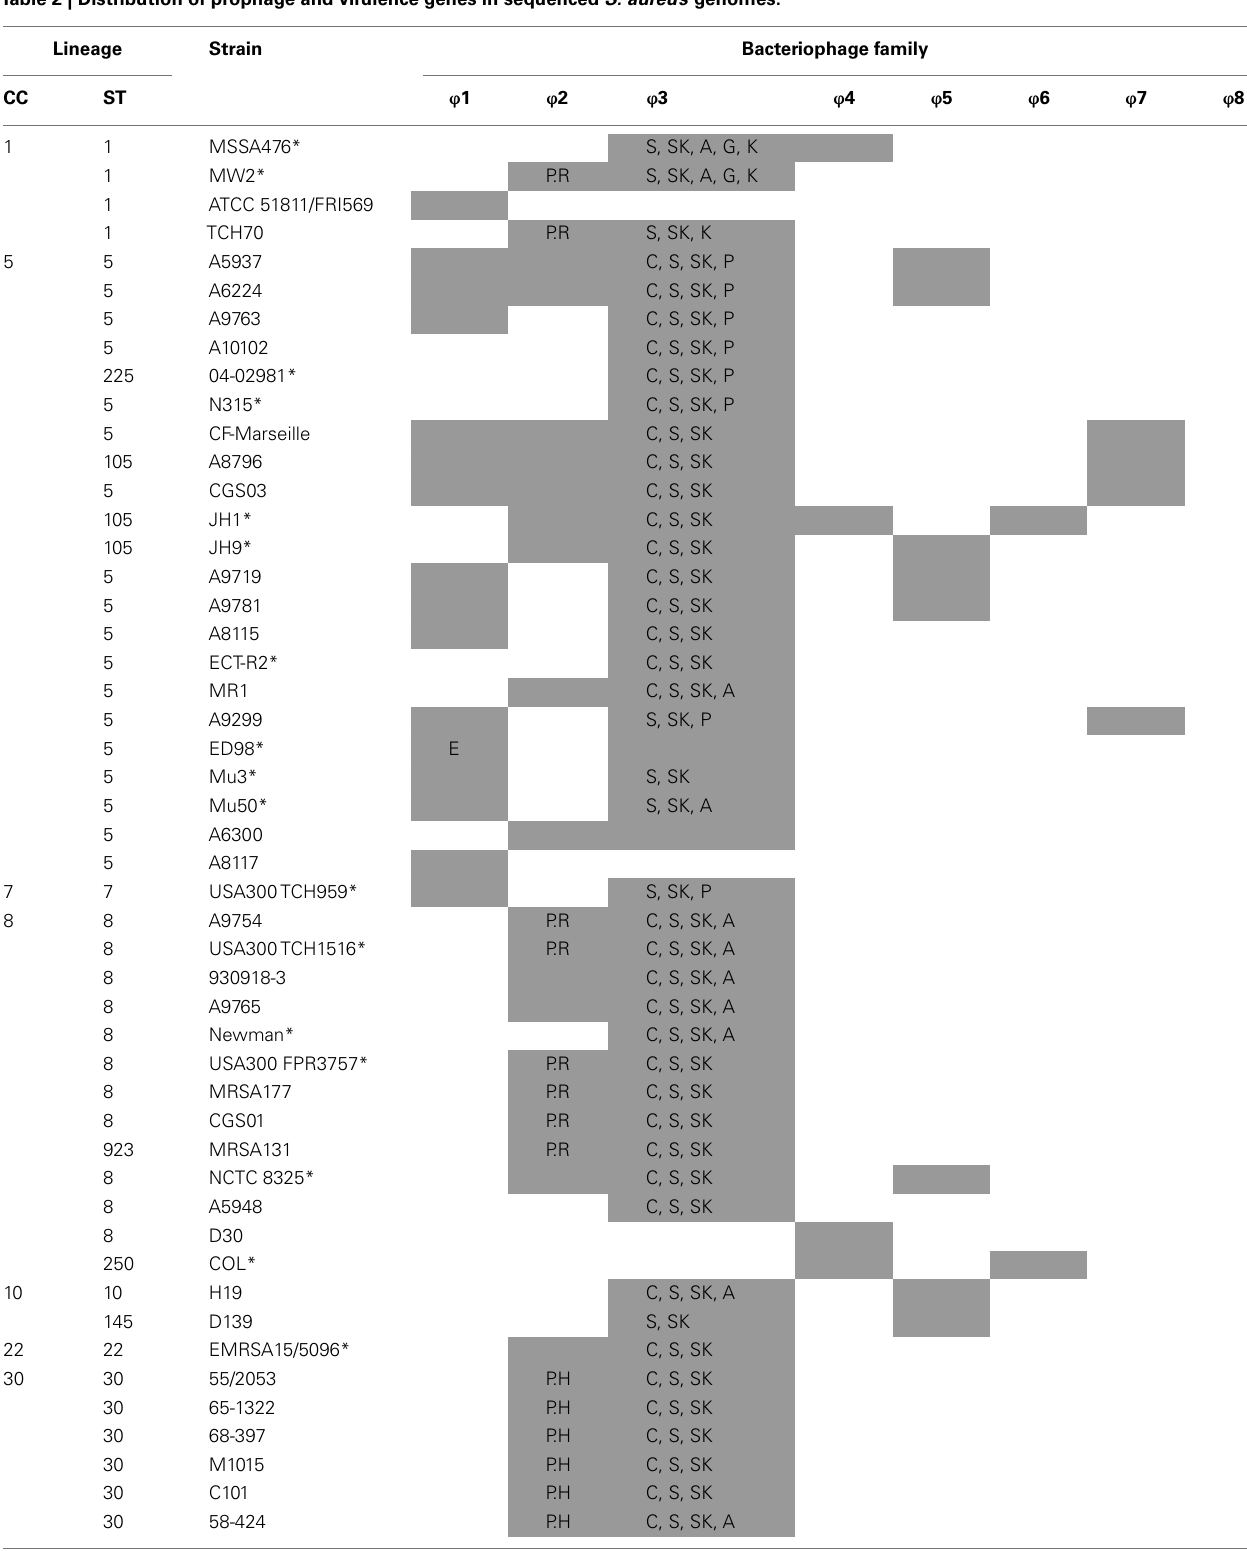
Table 2 | Distribution of prophage and virulence genes in sequenced S. aureus